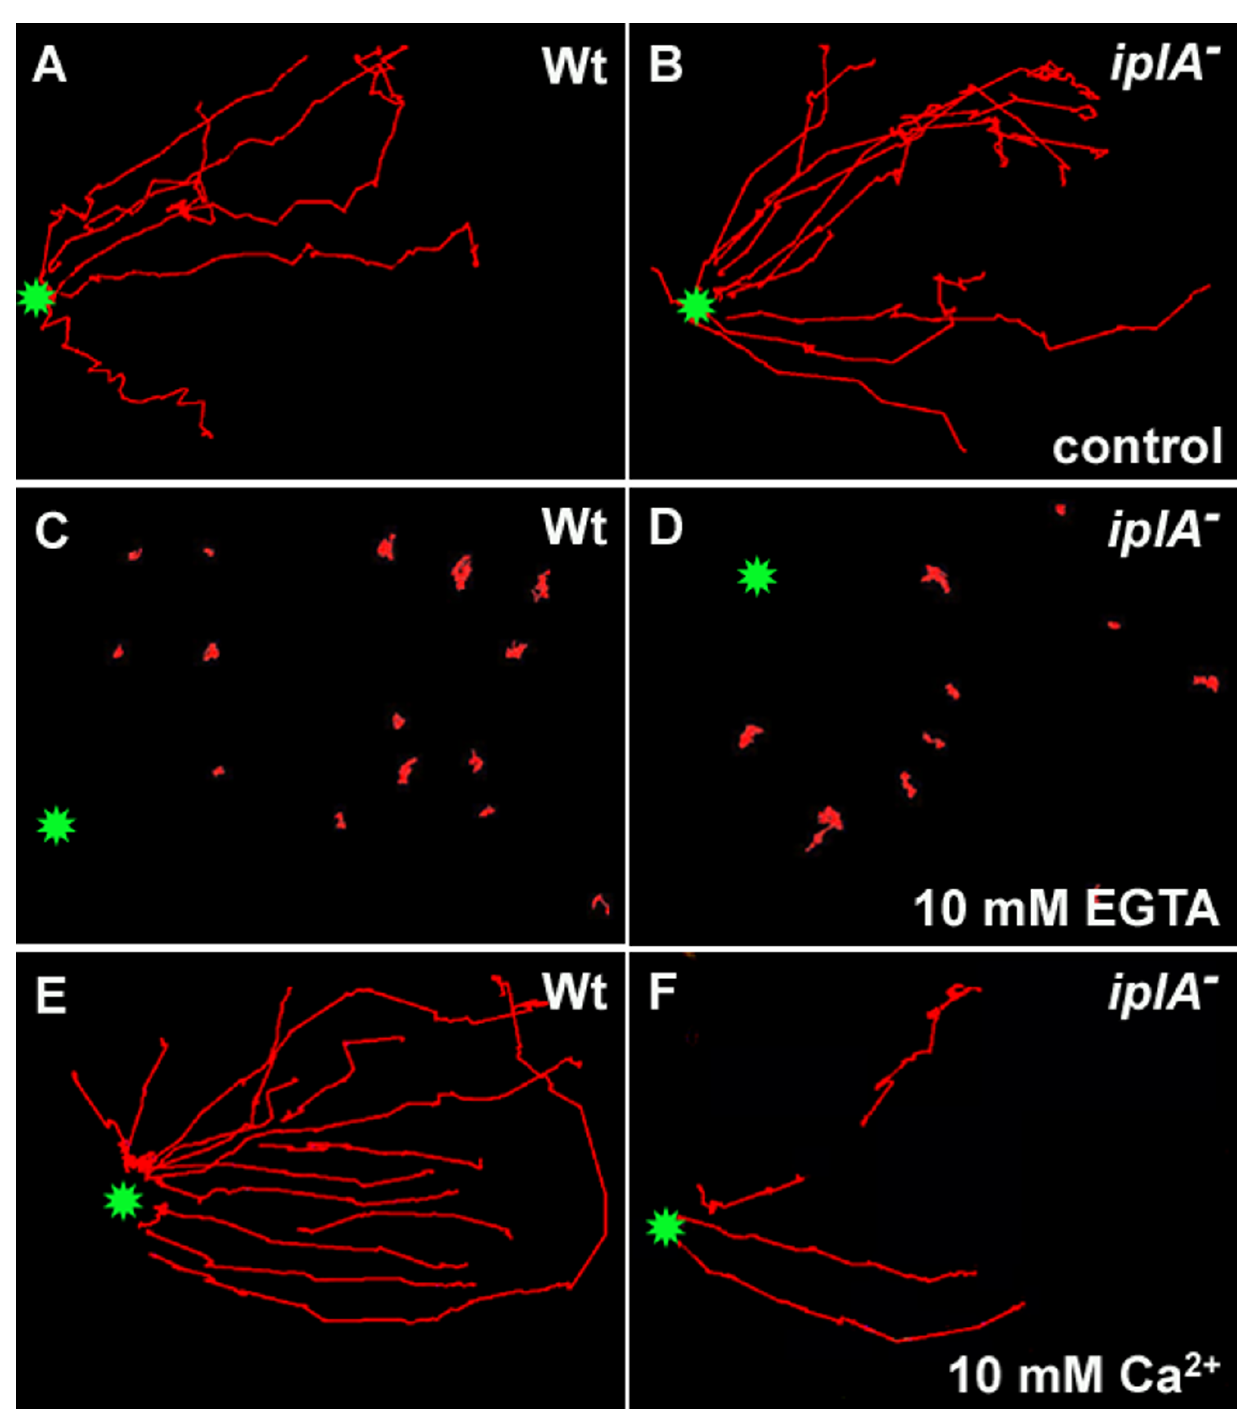
Figure 5 Chemotaxis of wild type and mutant amoebae at different experimental conditions. The tracks of individual cells (in red) migrating during chemotactic stimulation (position of the tip of the cAMP-filled capillary: green star) are shown. In H5-buffer (A, B) both cell types migrated in an oriented manner towards the capillary tip, albeit not always in a straight line. After prein- cubation with 10 mM EGTA for 60 min and in its continued presence during the chemotaxis assay (C, D) the cells remained stationary with random pseudopod extension. Preincubation of amoebae with 10 mM CaCl rather, the cells of both strains migrated towards the capillary tip. Chemotaxis experiments were done at t